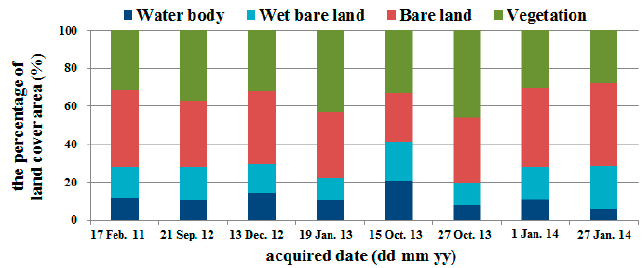
Figure 10. Land cover changes in the study area from 2011 to 2014 (model validation).